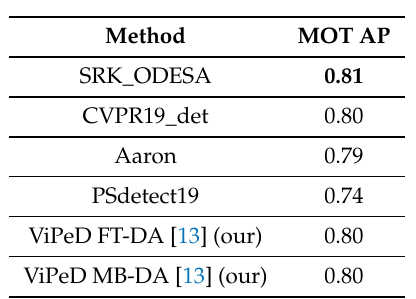
Table 3. Evaluation of the two DA techniques on the MOT19Det dataset. FT-DA (Fine Tuning DA) is the first proposed solution, while MB-DA (Mixed Batch DA) is the second one. Results are evaluated using the MOT mAP. We report in bold the best